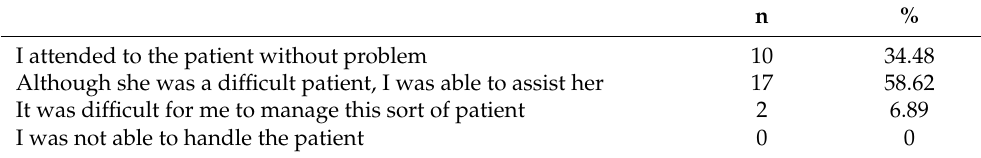
Table 4. Answers to question 2. The periodontology station was carried on with a simulated patient.